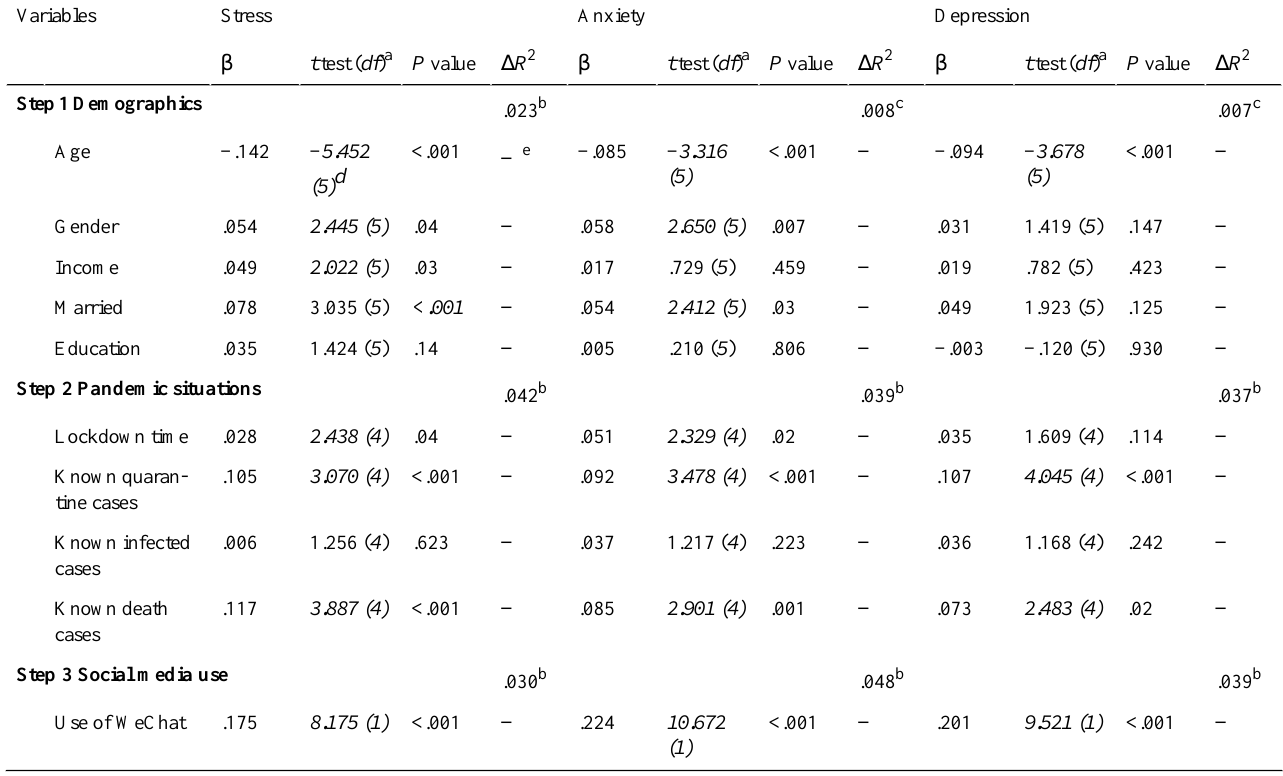
Table 4. Factors contributing to stress, anxiety, and depression.